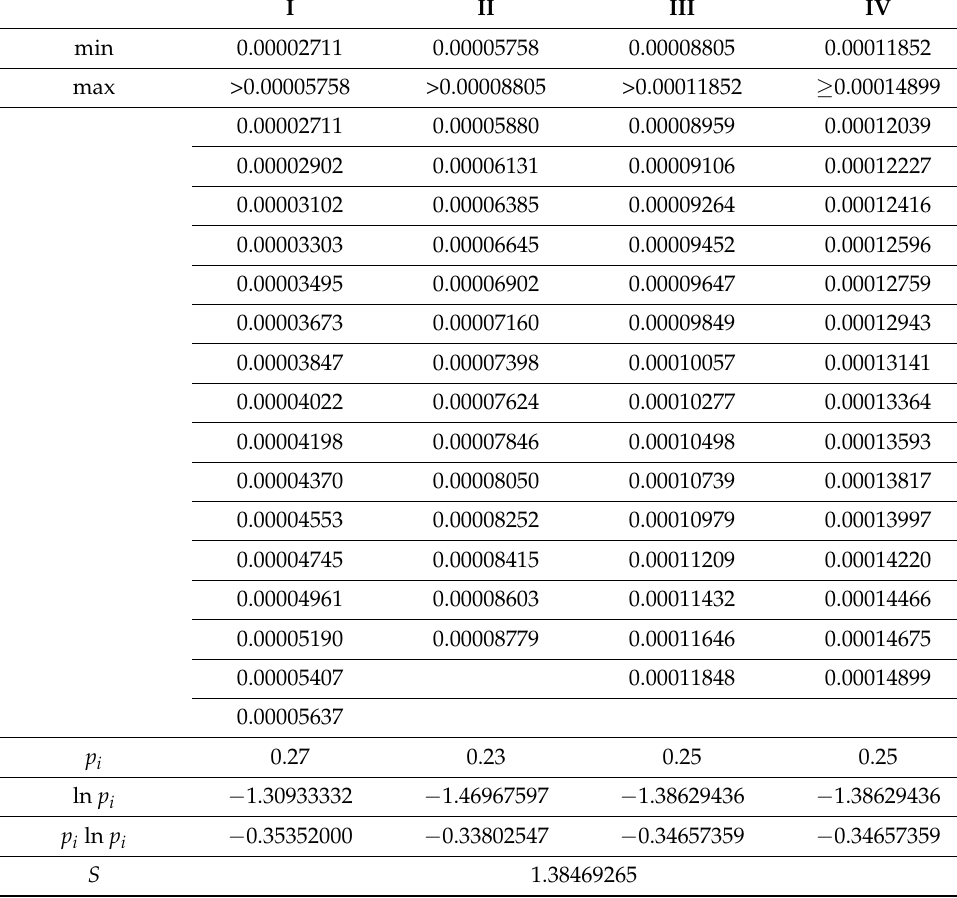
Table 3. Procedure of calculating K-S metric